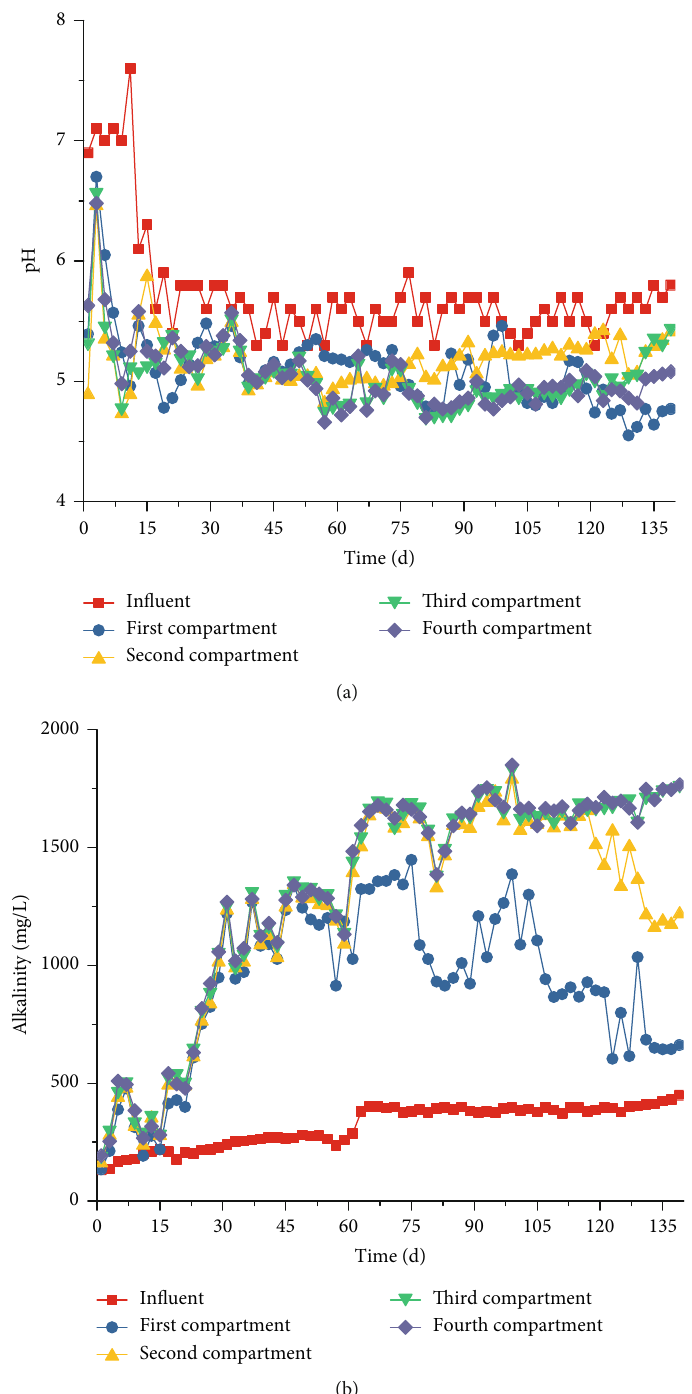
Figure 9: E ffl uent pH and alkalinity in each compartment ((a) pH; (b)